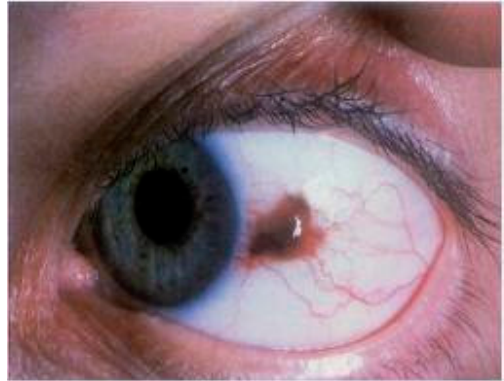
Figure 1. Slitlamp photograph of a conjuntival melanoma, histologically confirmed, with a tendency to invade the limbus and cornea.